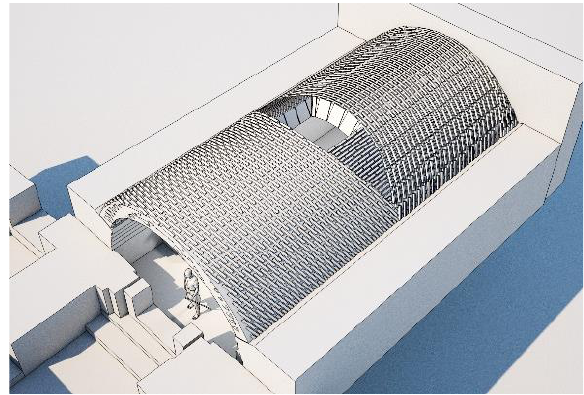
Figure 7. 3-D reconstruction of the vault of room 100 of the Casas del Turuñuelo site (Guareña, Badajoz).